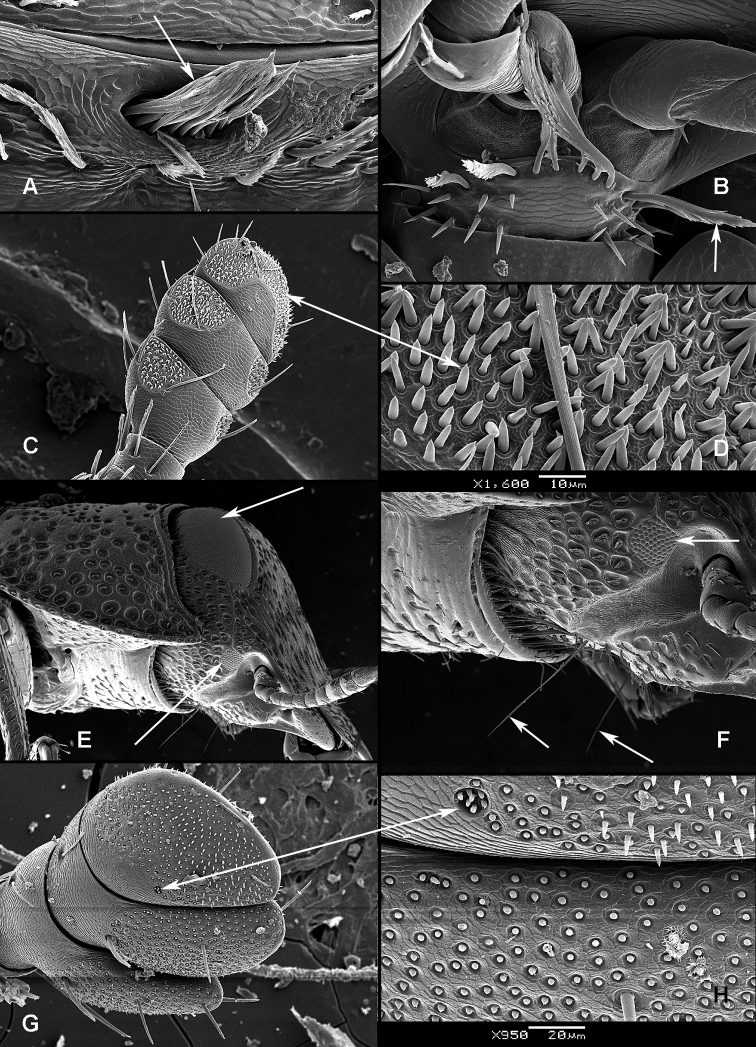
A–F
Anacypta sp., Assam (A ctenidium B labium with ciliate setae C antennal club with sensorial fields D detail of sensillae E head laterally with divided eye F detail of sensorial setae and ventral eye) G–H
Gymnocheilis sp., Cameroon (G antennal club H detail of sensillae).